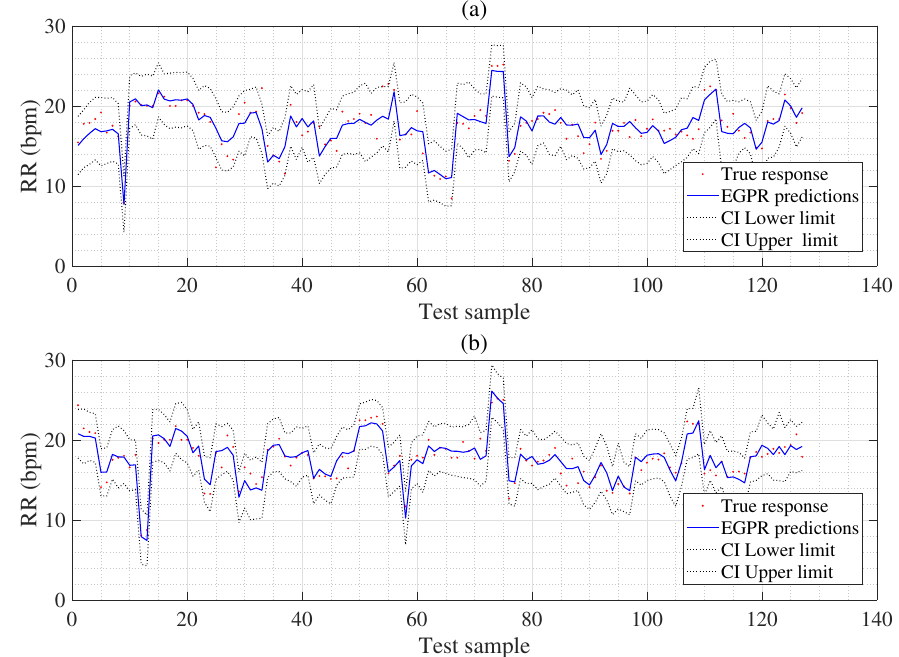
Figure 8. Top panel ( a ) denotes the CI estimation using the ECG-based EGPR-MF model to represent the uncertainty for RR estimation; bottom panel ( b ) is the CI estimation using the EGPR-FF model to represent the uncertainty for RR